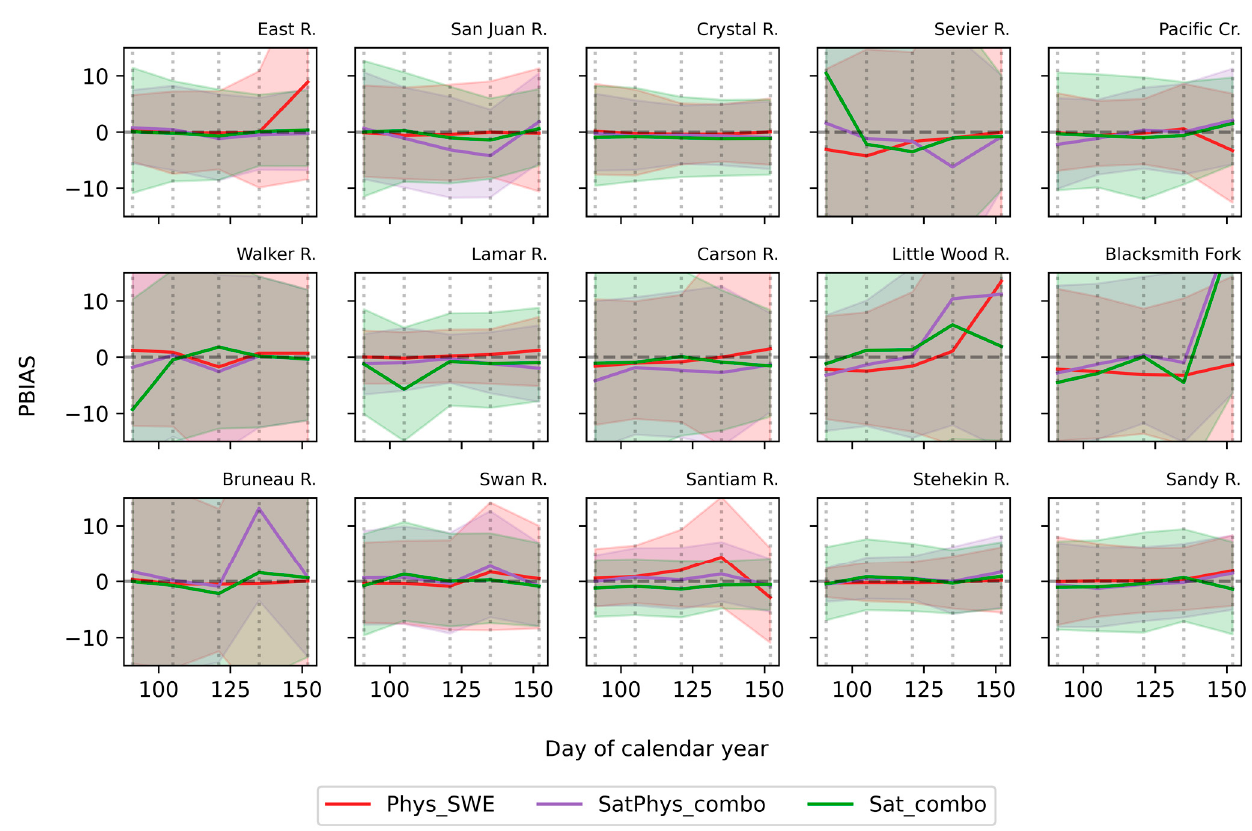
Figure 6. The median percent bias statistics for three different satellite and in-situ-based water supply forecasts with interquartile range shaded, for all 15 study basins. Vertical dotted lines denote the days chosen for forecasting—1 April, 15 April, 1 May, 15 May, and 1 June.